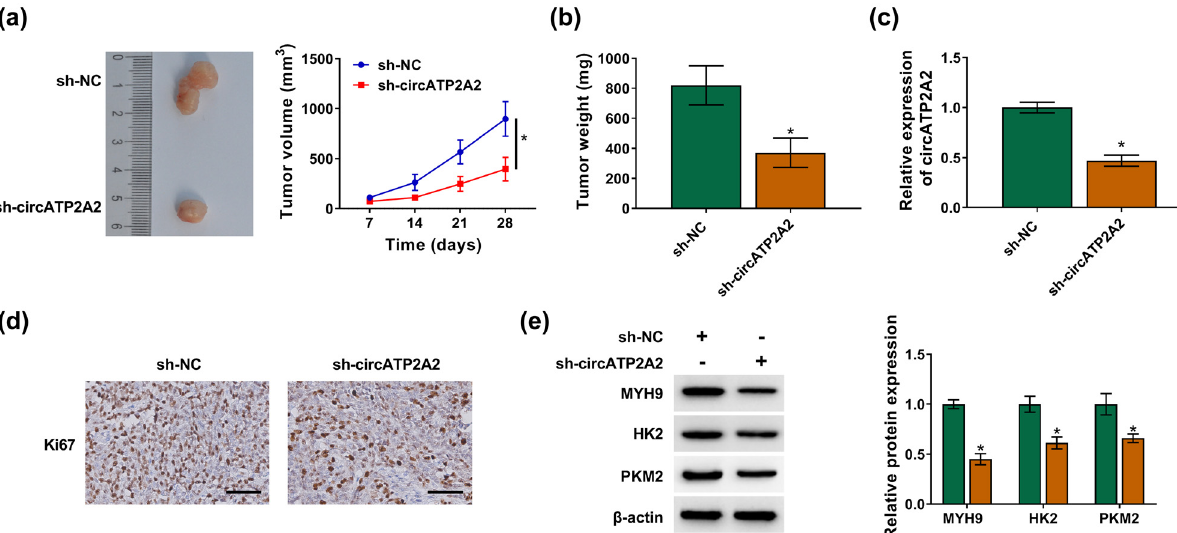
Figure 7: circATP2A2 inhibition decreased OS cell proliferation and glycolysis in vivo . ( a and b ) Tumor volume and weight of mice injected with OS cells carrying sh - circATP2A2 or sh - NC. ( c ) circATP2A2 expression in xenograft tumors in the sh - circATP2A2 and sh - NC groups was analyzed by RT - qPCR. ( d ) The level of Ki67 in xenograft tumors in the sh - circATP2A2 and sh - NC groups was analyzed by IHC. ( e ) Protein levels of MYH9, HK2 and PKM2 in xenograft tumors in the sh - circATP2A2 and sh - NC groups were detected by Western blotting. * P <